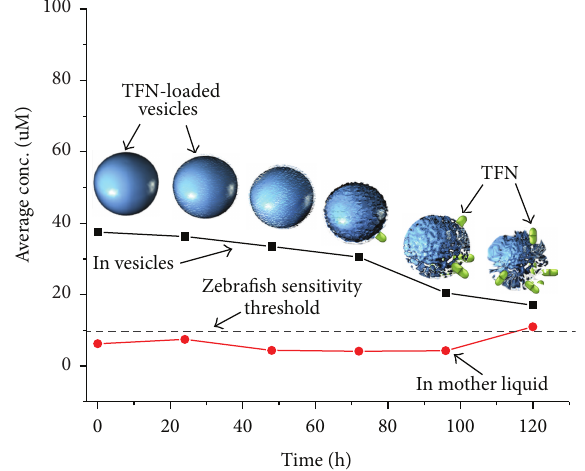
Figure 11: TFN concentration change inside vesicles and in mother liquid at different time points. Cartoon represents slow deformation of vesicles and TFN “burst” drug release after 72